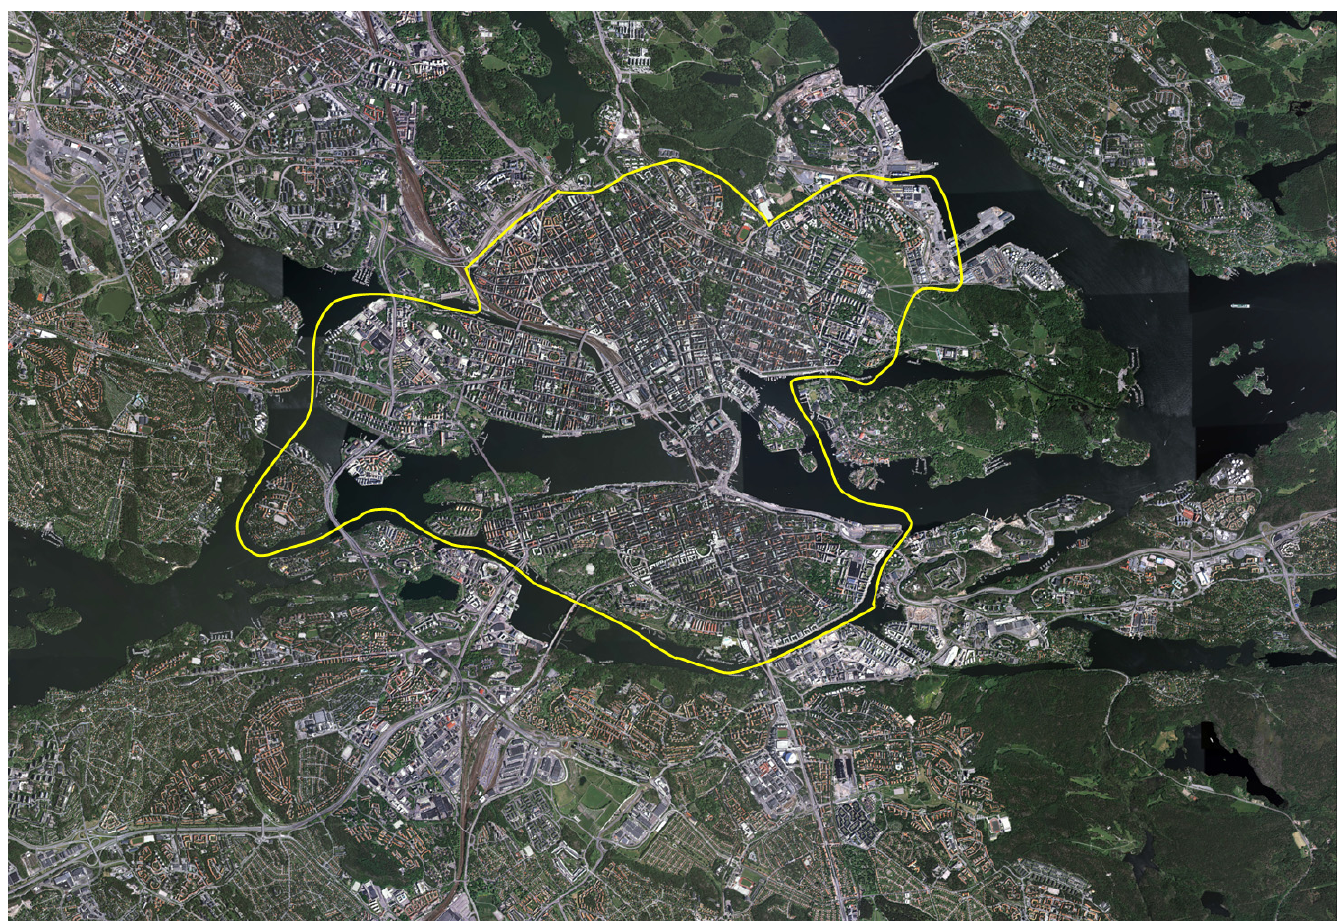
Figure 1. Aerial view from 2005 over the more central parts of Greater Stockholm, Sweden. The yellow line distinguishes the inner urban and the suburban, as well as rural parts, of the area. For a description of the characteristics of the suburban area, see Methods. (Copyright is granted from Lantmäteriverket, Gävle, Sweden in